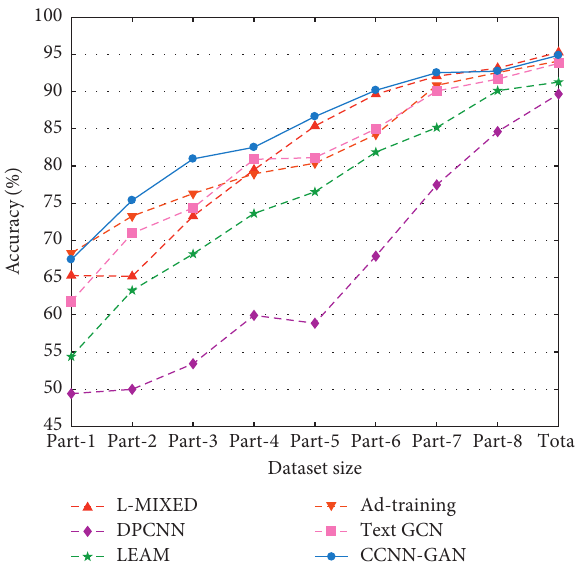
Figure 7: The performance on IMDB semisupervised classification